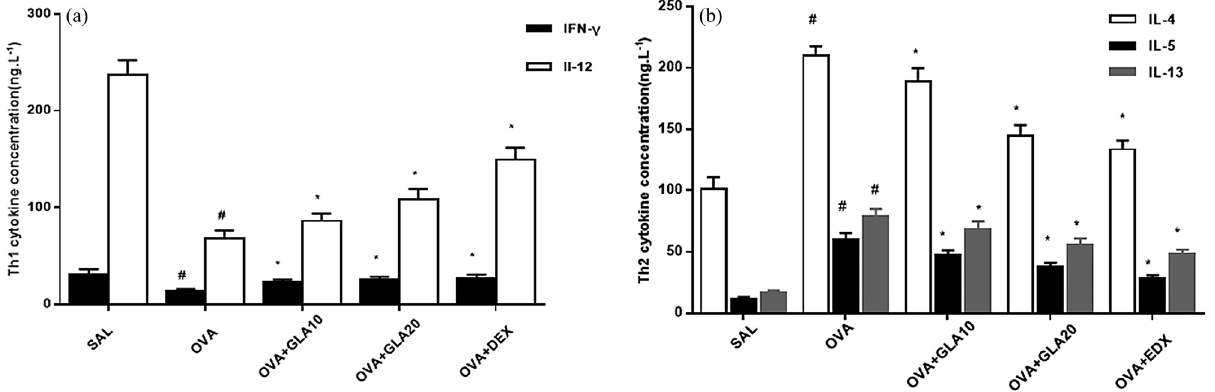
Figure 6: E ff ects of GLA on cytokine expression levels. ( a ) Levels of IL - 4, IL - 5, and IL - 13 in the BALF were analyzed using ELISA. ( b ) Levels of IL - 12 and IFN - γ in the BALF were analyzed using ELISA. Compared with the SAL group, # P < 0.05; and compared with the OVA - sensitized group, * P < 0.05. N = 3; analyzed by ANOVA.